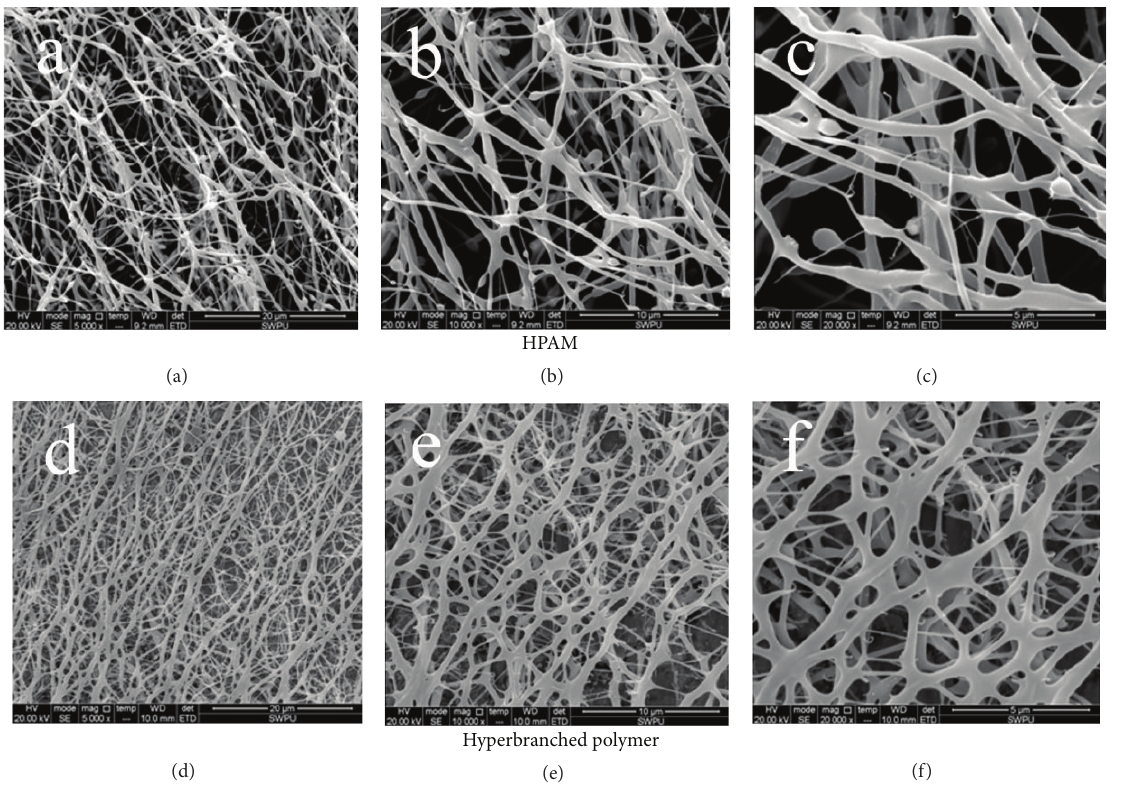
Figure 6: SEM images of HPAM and hyperbranched polymer: (a) HPAM solution at 20 𝜇 m, 5000x; (b) HPAM solution at 10 𝜇 m, 10000x; (c) HPAM solution at 5 𝜇 m, 20000x; (d) hyperbranched polymer solution at 20 𝜇 m, 5000x; (e) hyperbranched polymer solution at 10 𝜇 m, 10000x; (f) hyperbranched polymer solution at 5 𝜇 m,